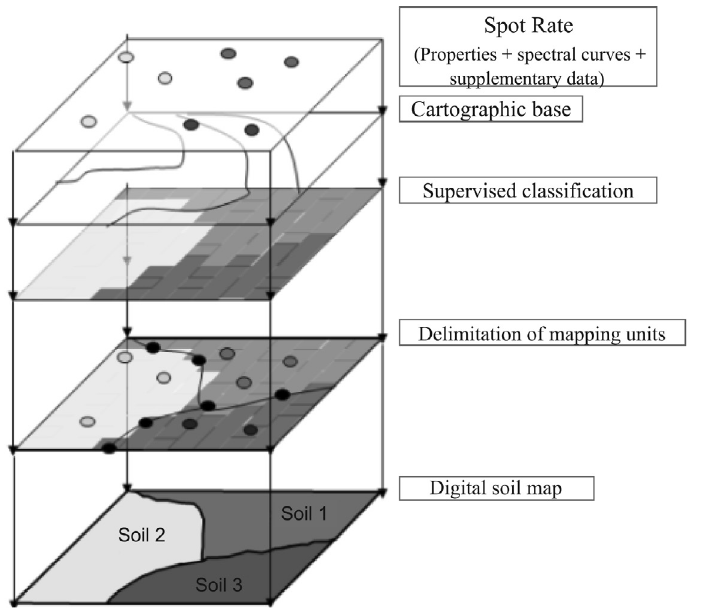
figure 3. illustration of the arrangement of information layers that composed the digital soil